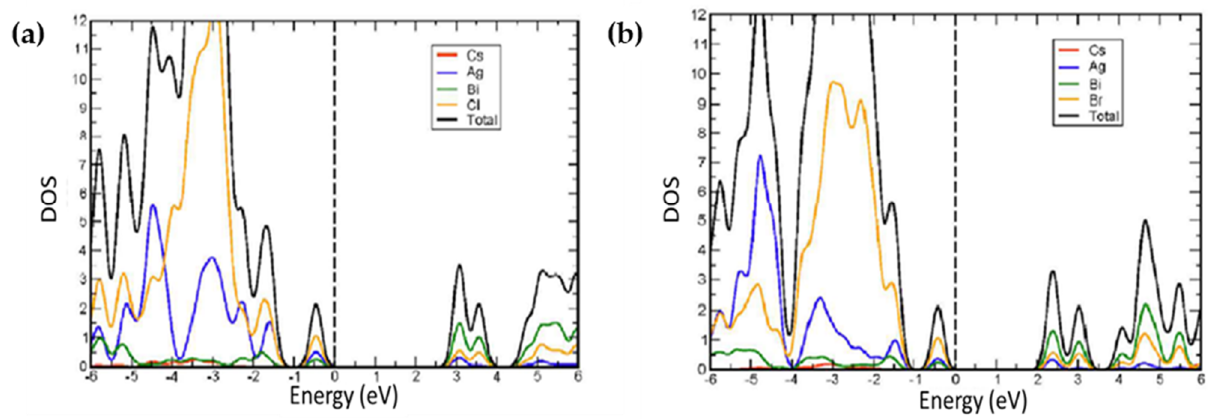
Figure 2. Atomic partial density of states for; ( a ) Cs 2 AgBrBr 6 and; ( b ) Cs 2 AgBrCl 6 . Reproduced with permission from [49]. Copyright 2016, American Chemical Society.